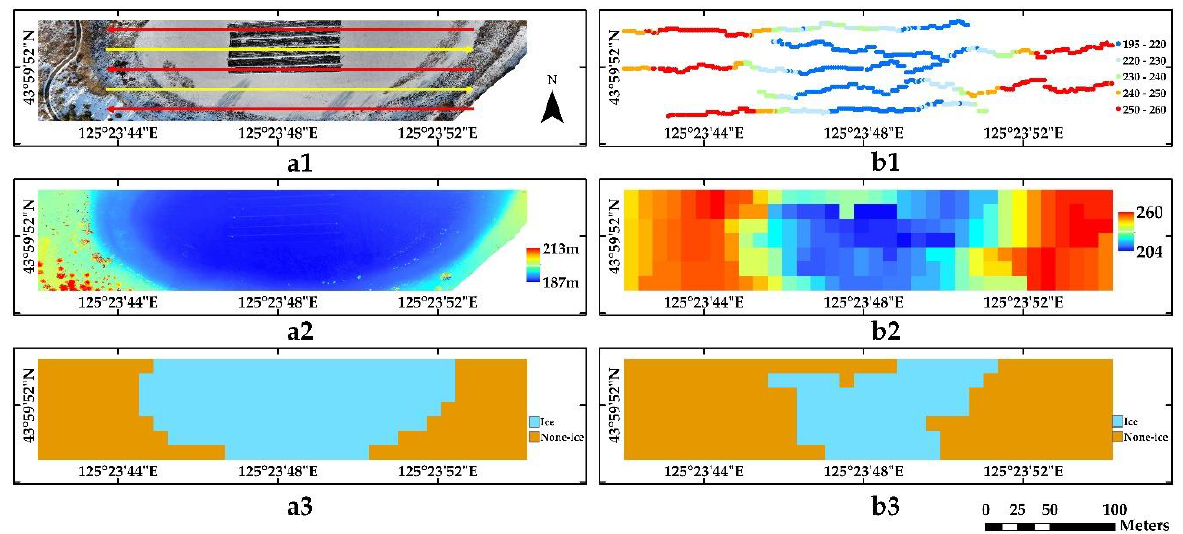
Figure 14. Display of flight test results. ( a1 ) Optical image and the flying routes; ( a2 ) DSM image; ( a3 ) classfication results of optical image; ( b1 ) TB swath data; ( b2 ) TB gridded data; ( b3 ) classfication results of TB.